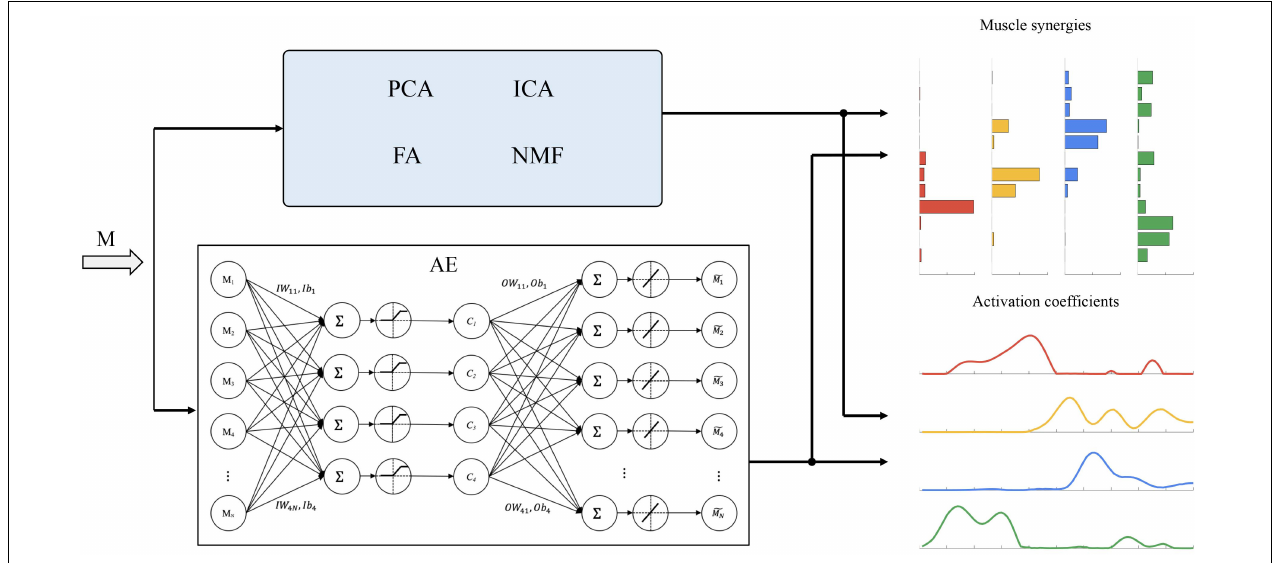
FIGURE 2 | Schematic representation of the extraction methods considered in this study. Principal component analysis (PCA), independent component analysis (ICA), factor analysis (FA), and non-negative matrix factorization (NMF) follow a similar procedure for synergy extraction, which factorizes muscle activations (M) into a set of muscle synergies and corresponding activation coefficients. The topology structure of the autoencoders used in this study is also